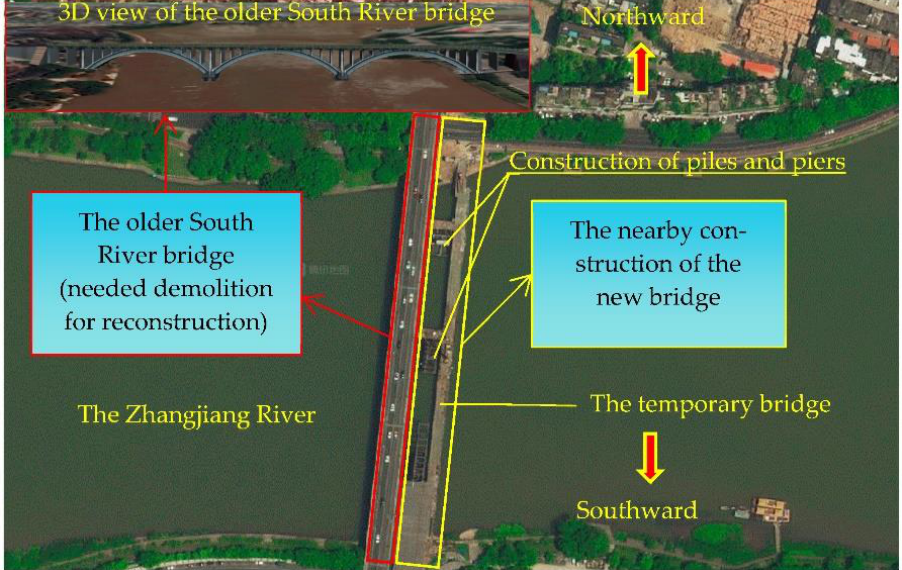
Figure 1. The satellite image of the South River bridge.